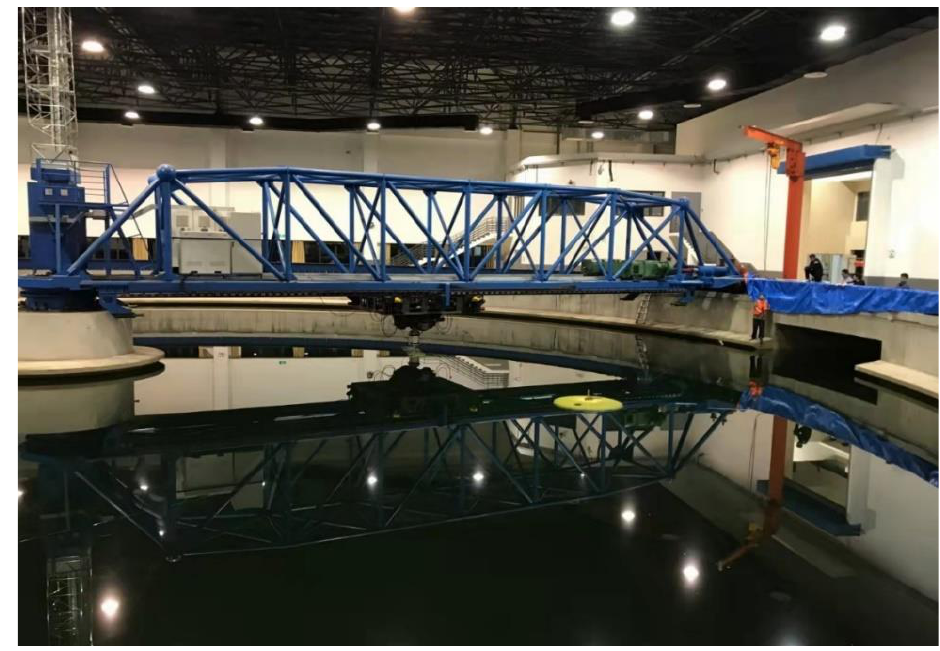
Figure 17. Testing water pool.